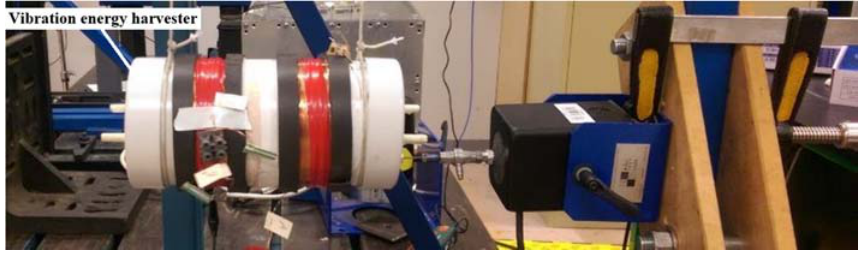
Figure 5. The cylindrical tube electromagnetic energy harvester excited by a shaker.